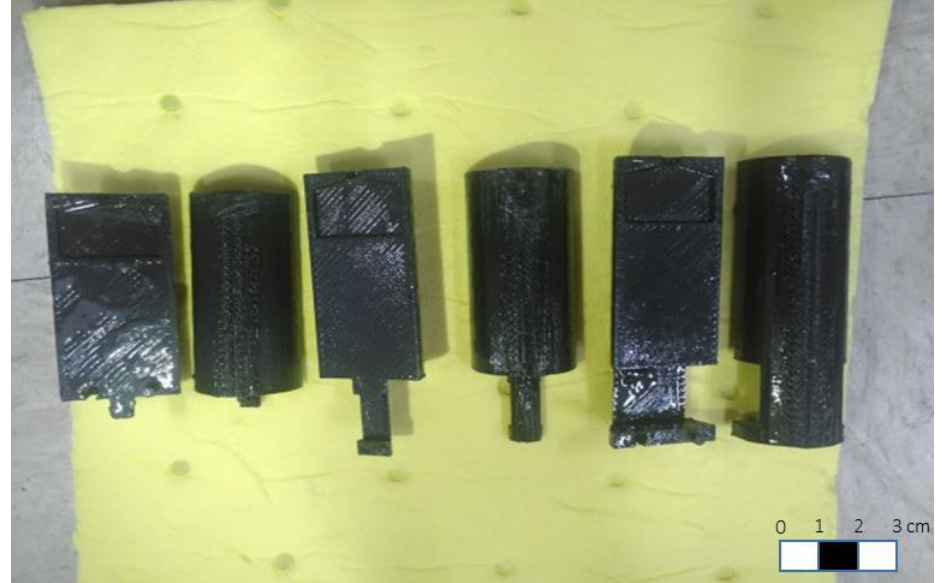
Figure 2. Micro-sensor housing after soaking.